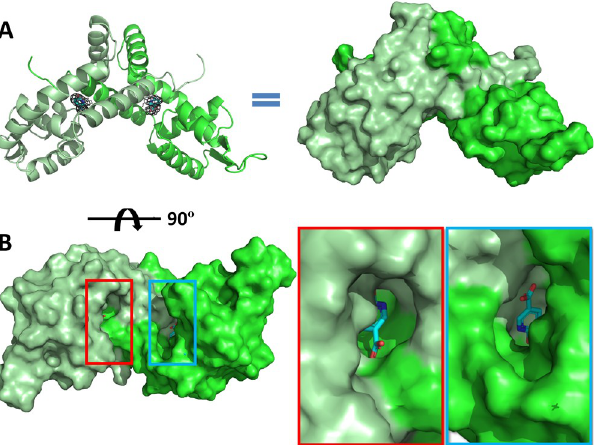
PLOS ONE | https://doi.org/10.1371/journal.pone.0223387 November7,